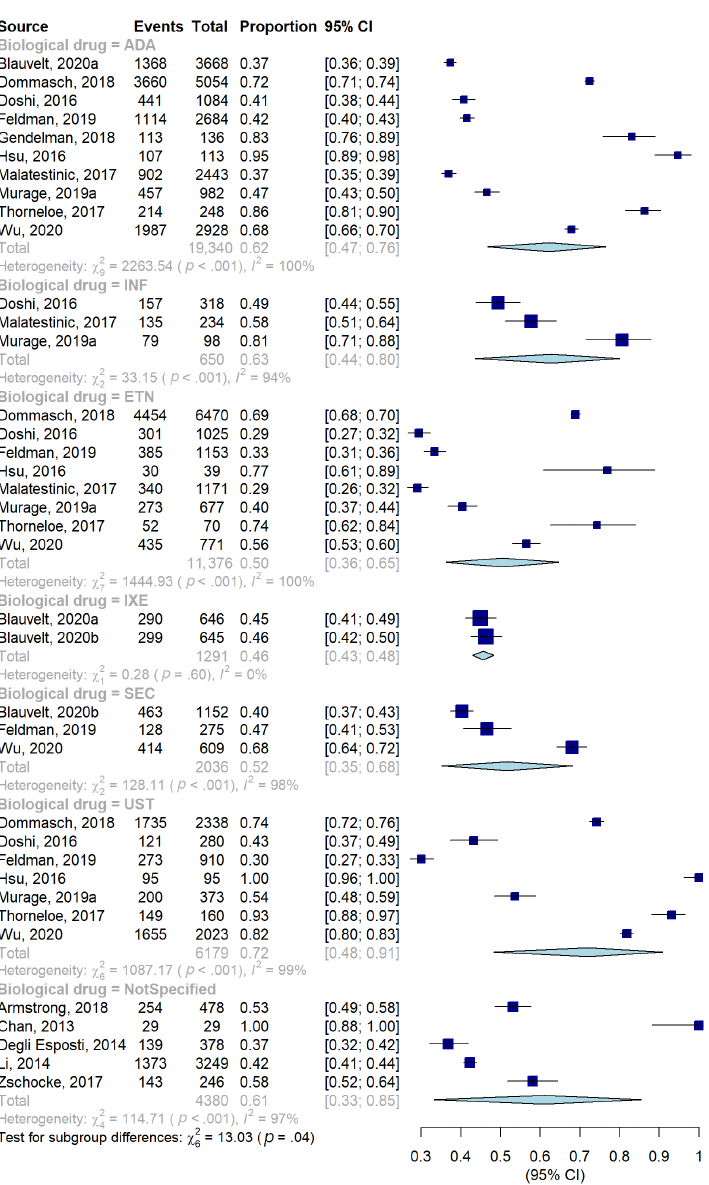
Figure 3. Forest plot of proportions, and their 95% confidence intervals, of adherent patients stratified according to biological drugs.